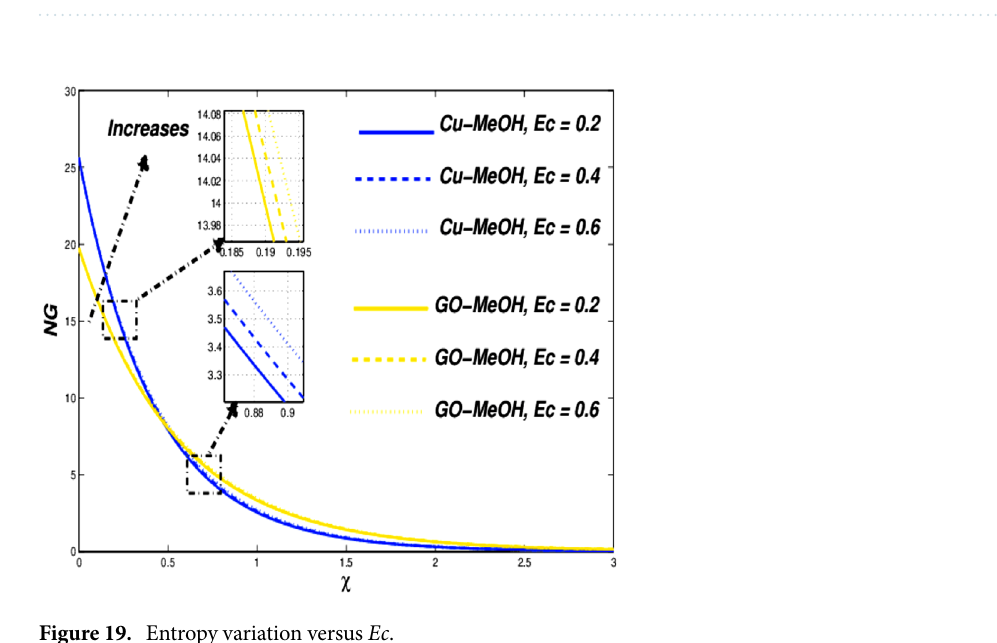
Figure 18. Temperature variation versus Ec .